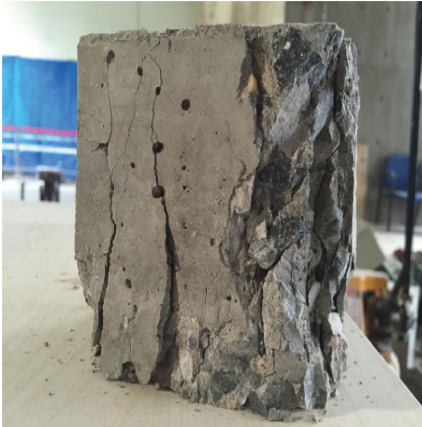
Figure 3: Failure pattern of a cubic ordinary concrete specimen under